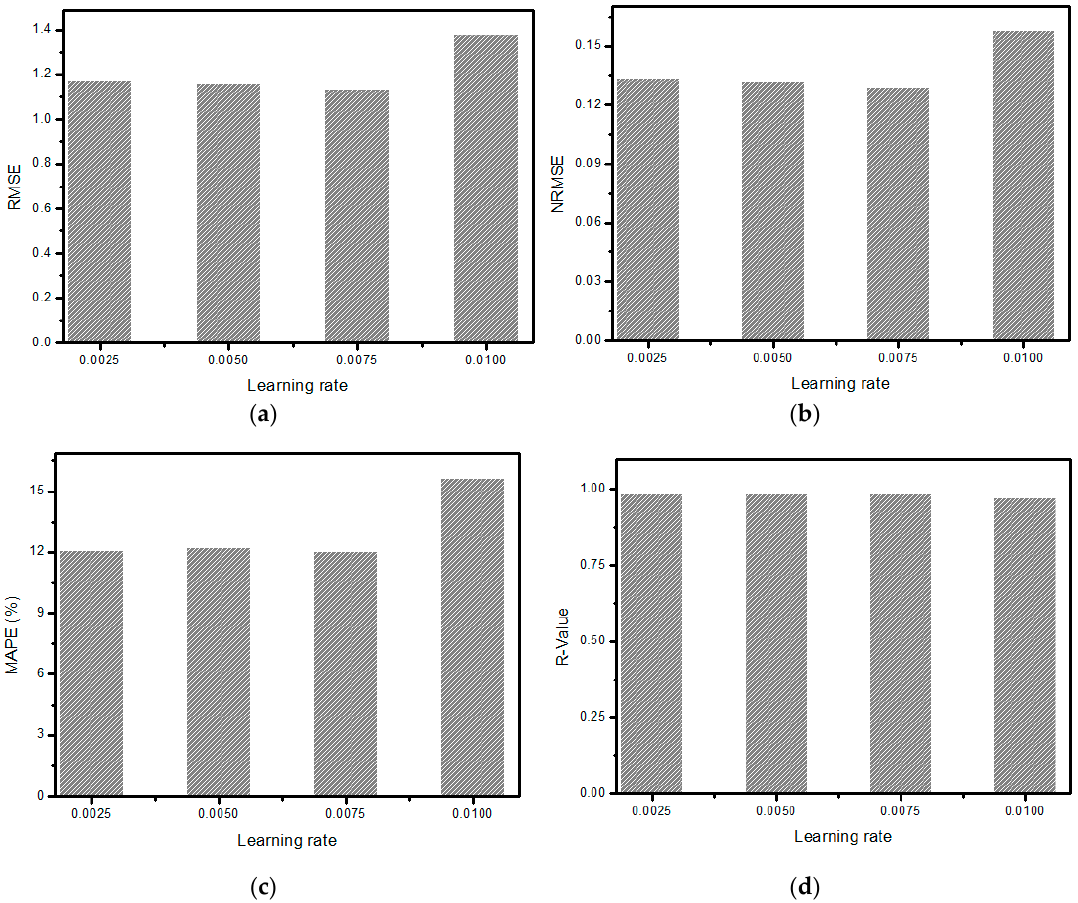
Figure 12. Performance parameters comparison of the GD algorithm for different learning rates. ( a ) RMSE; ( b ) NRMSE; ( c ) MAPE (%); ( d ) R value.